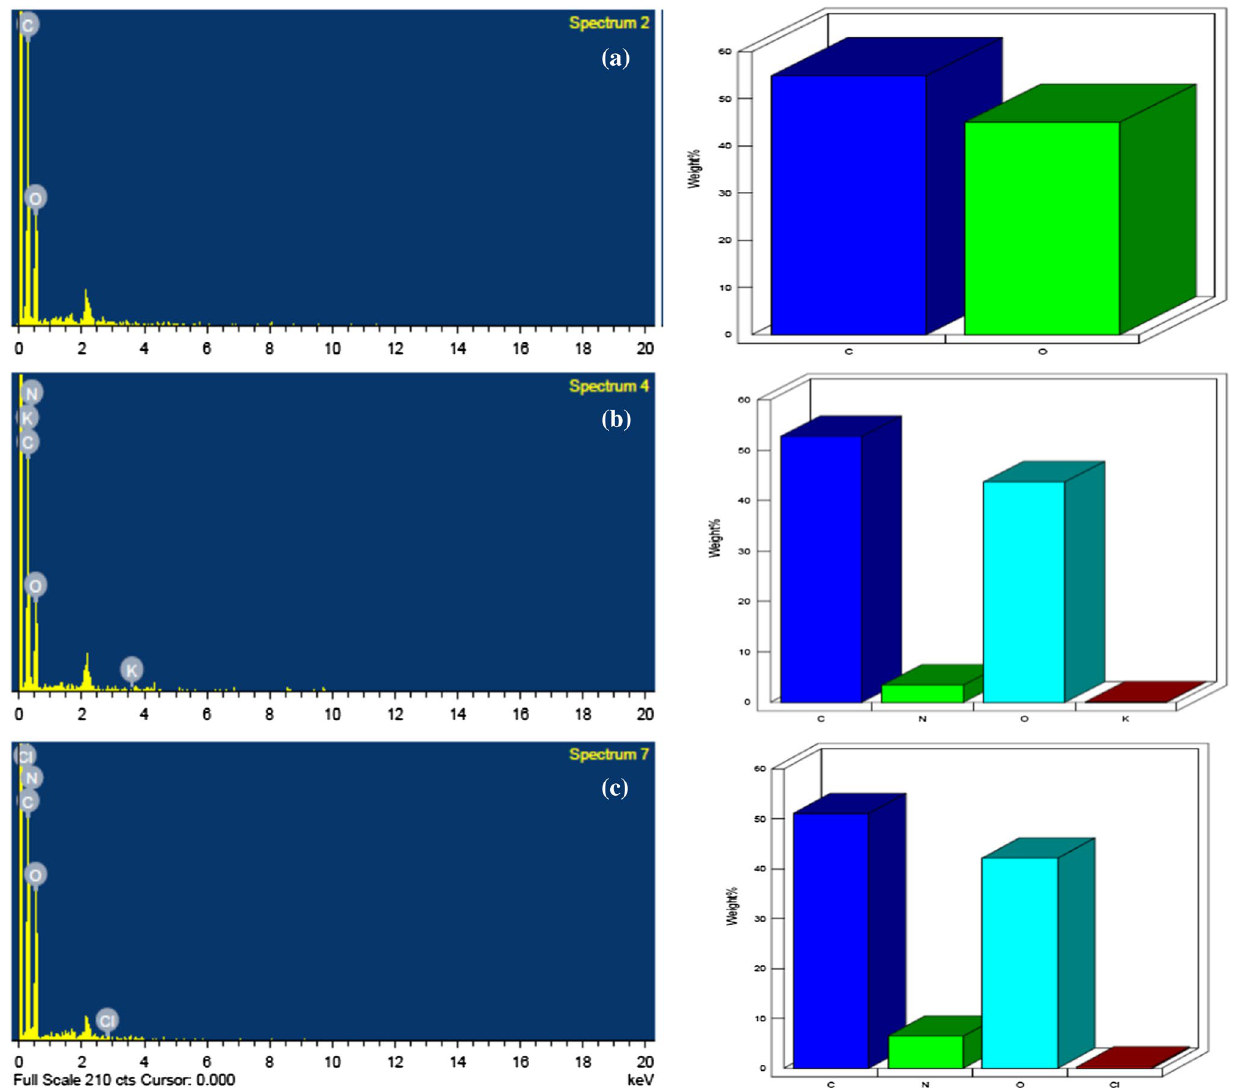
Fig. 3 EDX spectra a raw ADP b PGADP c PGADP after CV